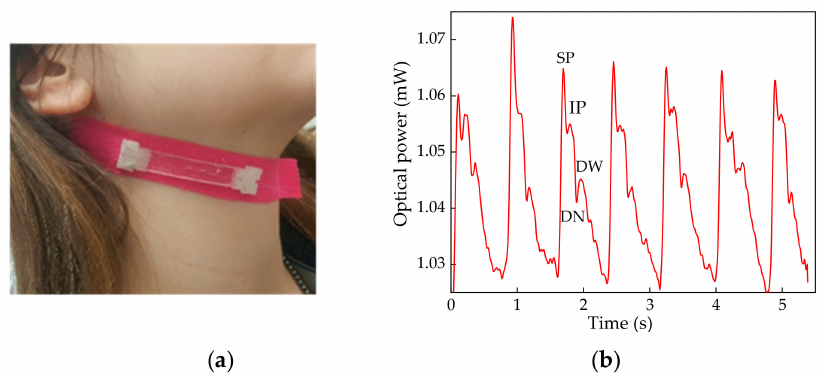
Figure 10. ( a ) Application of the biocompatible sensing block for carotid pulse wave monitoring; ( b ) Optical power variation according to the FPI modulation by the carotid pulse wave along the